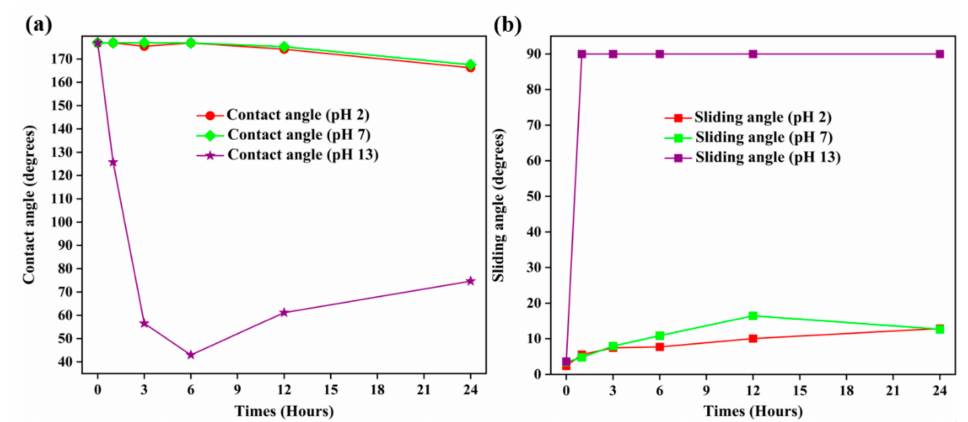
Figure 12. Results of the chemical stability test upon immersion in acidic, neutral, and alkaline solutions for the fabricated superhydrophobic coated films with a relative SNP weight ratio of 100%: ( a ) CA and ( b )